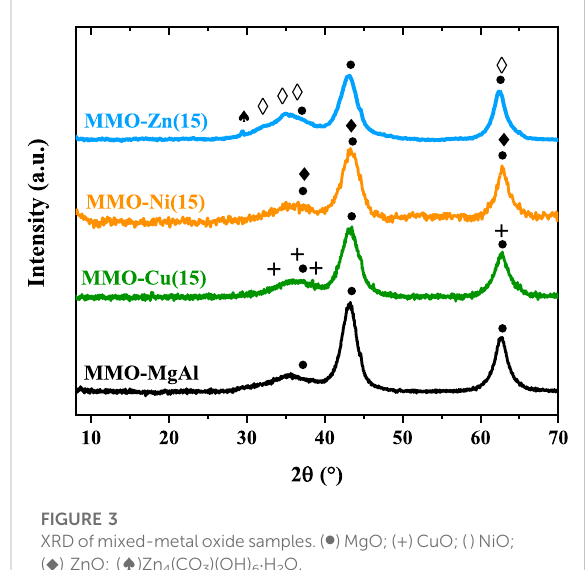
(cid:129) )MgO;(+)CuO;()NiO;